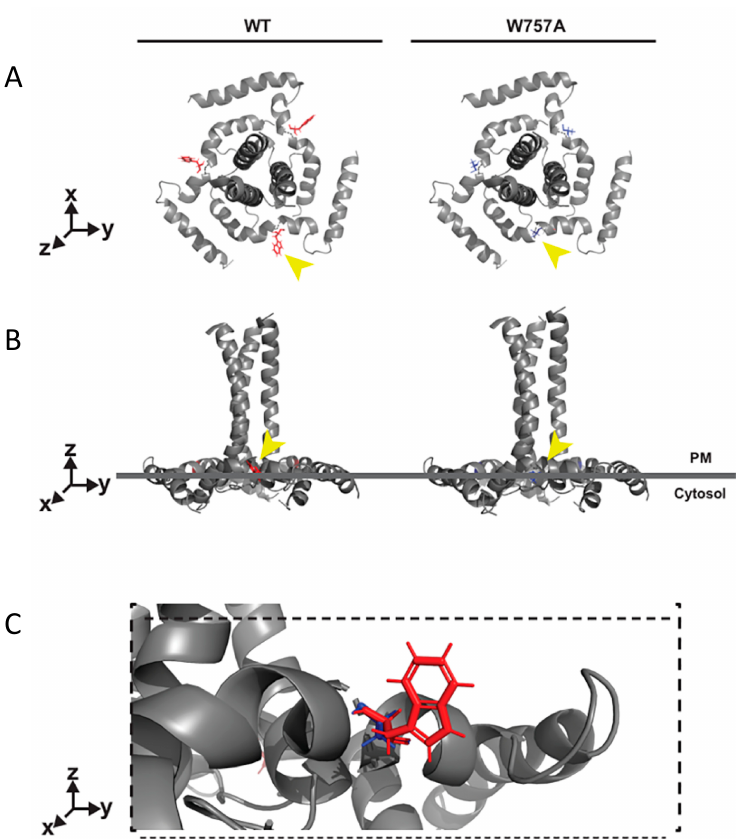
Figure 8. W757 within the EnvCT LLP2 helix may stabilise the EnvCT baseplate. ( A ) Top-down and ( B ) side-on models of trimeric EnvCT and TMD within the plasma membrane. Tryptophan (red) and alanine (blue) are highlighted in ( C ). The aromatic side chain of W757 (indicated by the yellow arrow) is predicted to be buried into the membrane, maintaining the EnvCT baseplate conformation, whereas alanine substitution at this position may allow for more conformational flexibility in the